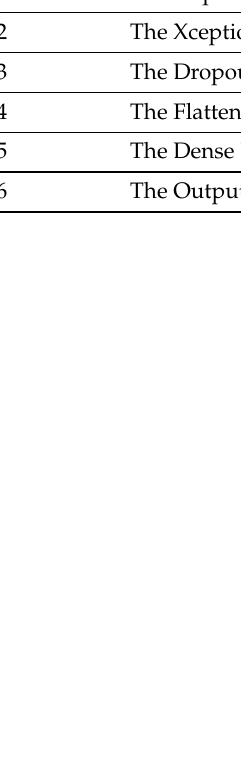
Table 3. The NAS-Net model configuration parameters and layer architectural